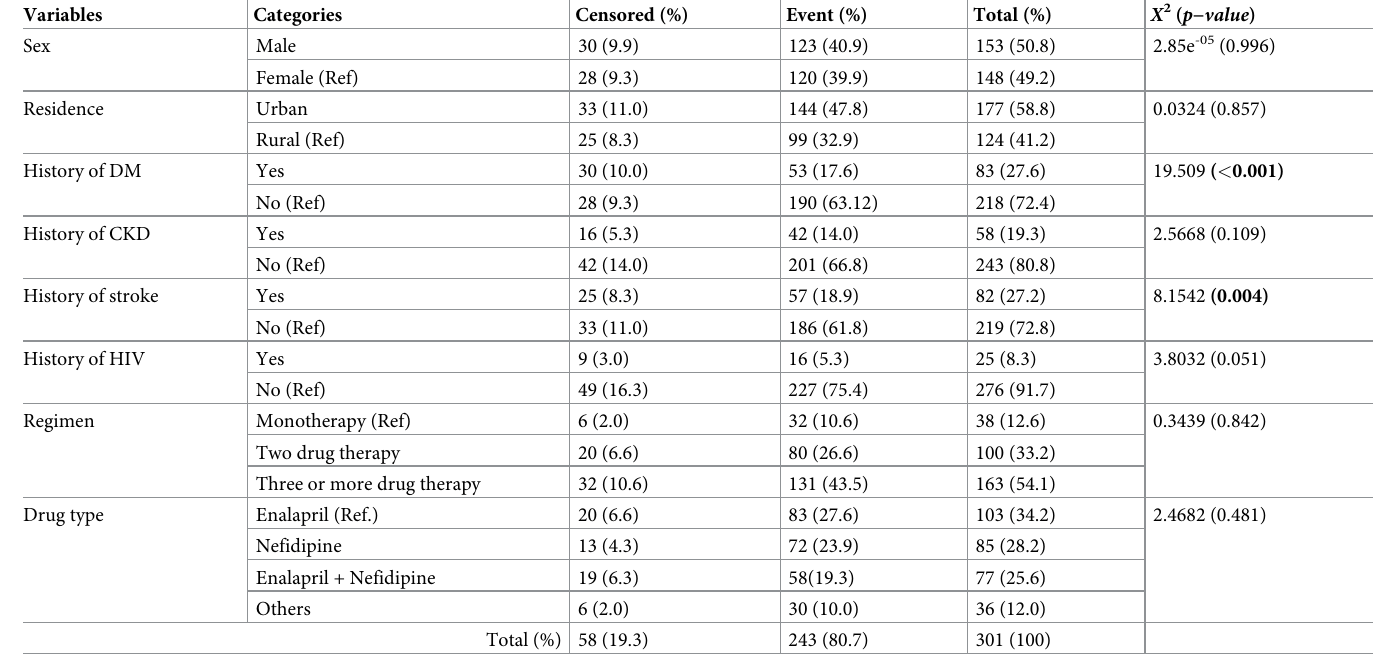
Table 2. Frequency distribution for baseline independent variables together with the censored observations of time-to-first remission and their association.